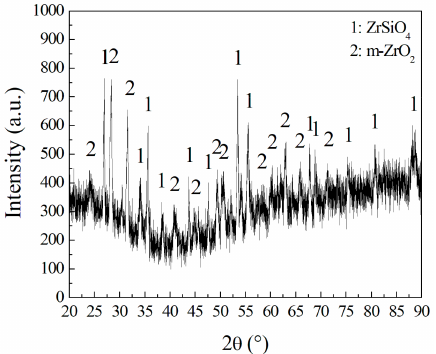
Figure 6. XRD pattern of laser cladding coating after oxidation at 1600 °C and 80 min.